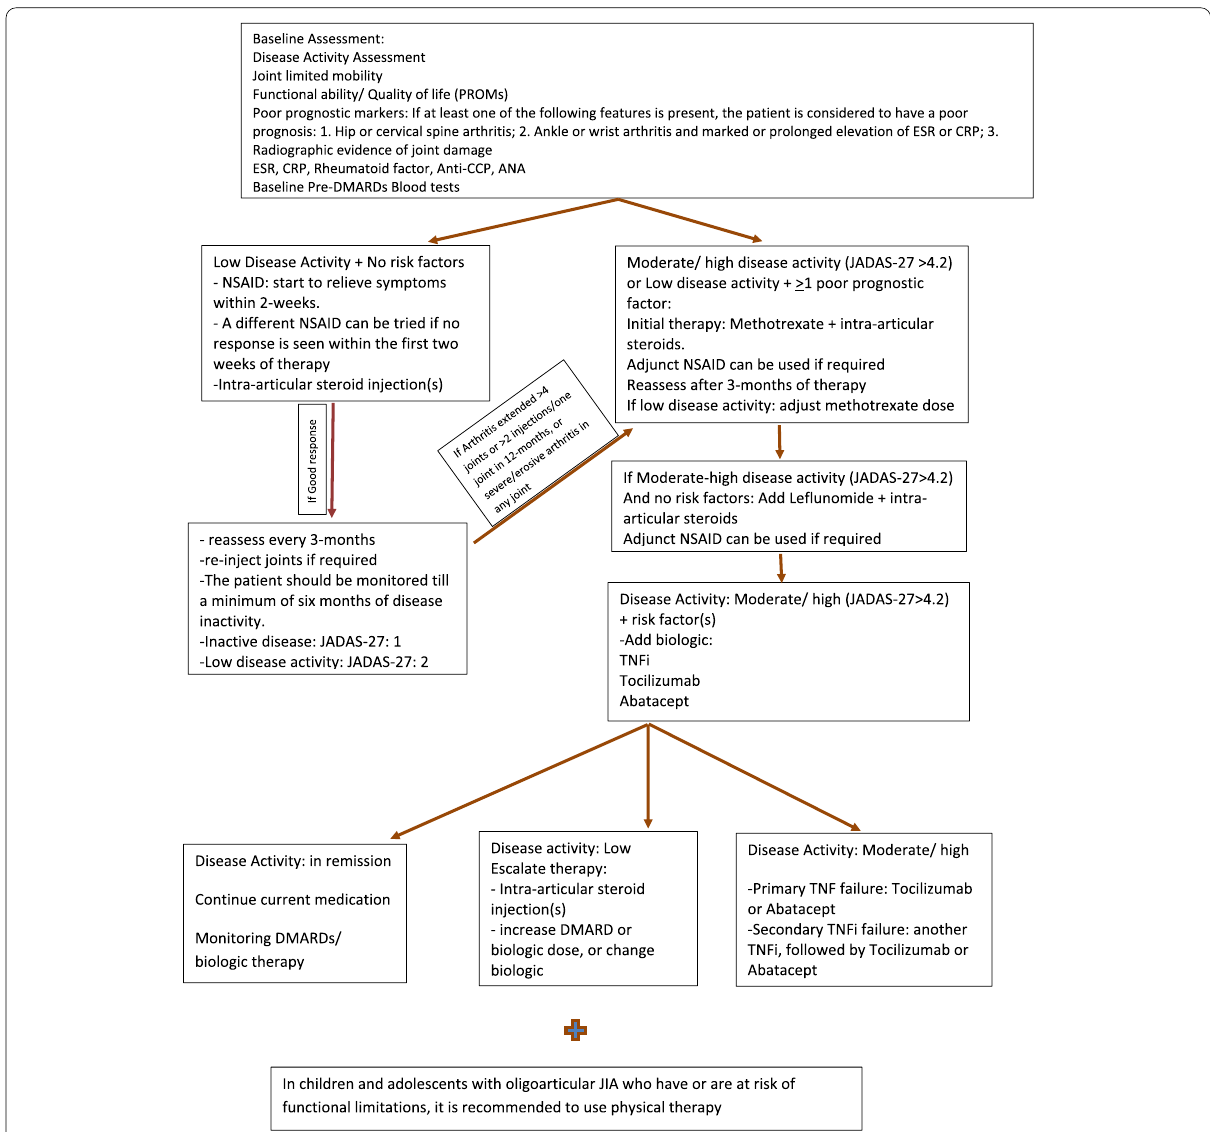
Fig. 3 Showing the treat-to-target management algorithm for oligoarthritis